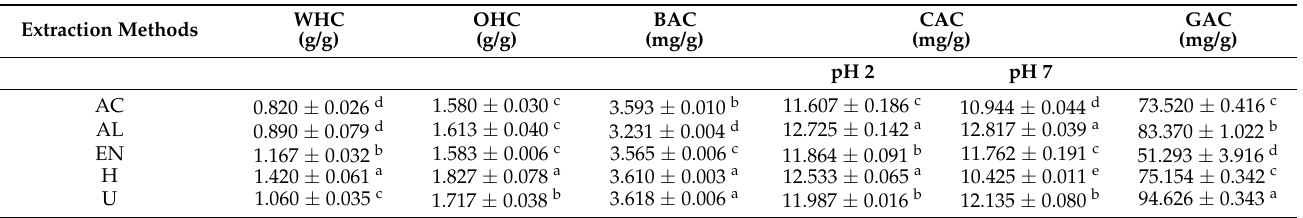
Table 4. Hydration and functional properties of Sanchi flower dietary fiber extracted by different